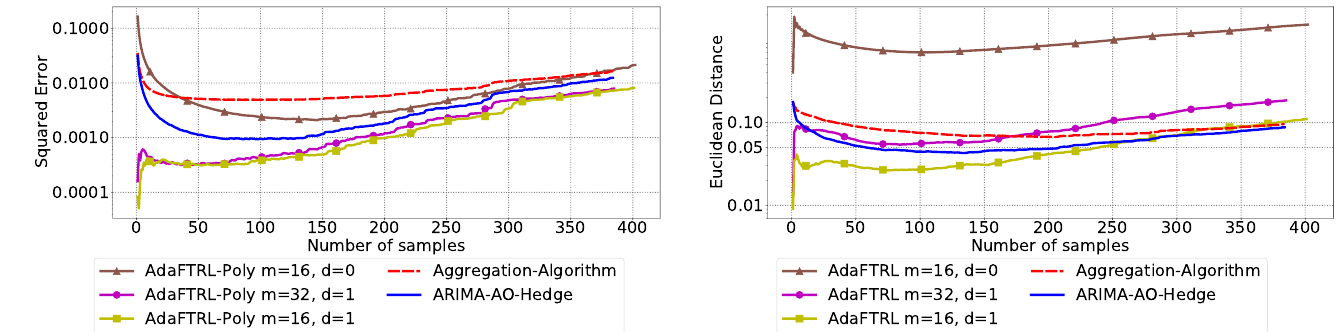
Figure 12. Model Selection for electricity